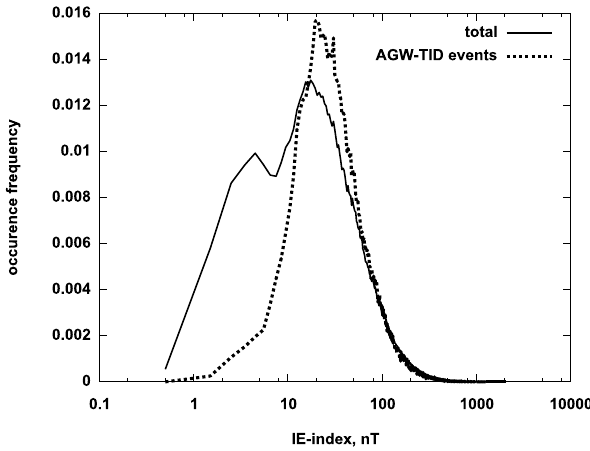
Fig. 19. The distributions of IE-index values recorded during the whole IPY-run (solid line) and of those recorded during the AGW- TID periods. The distributions have been normalized with the cor- responding total numbers of